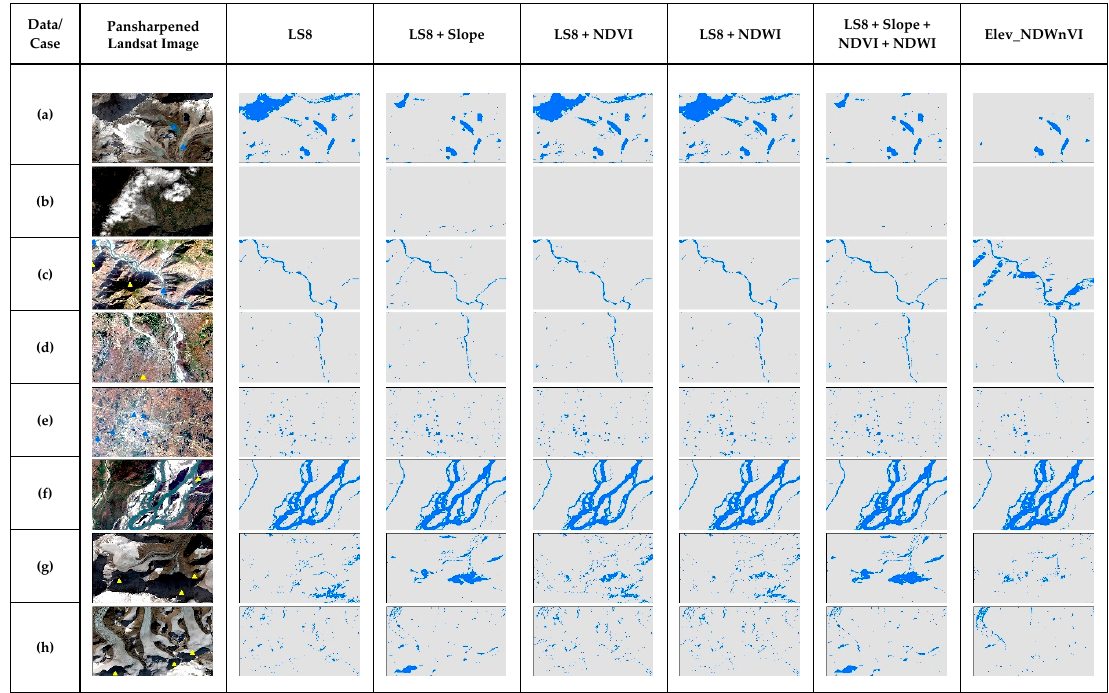
Figure 9. The comparison of SVM results of special cases of surface water in the test scene (Figure 2) for different multiband data used.